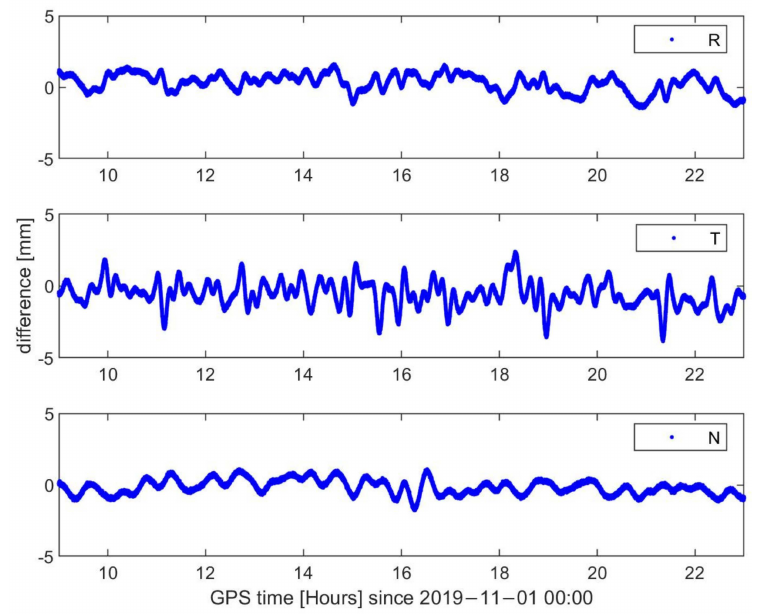
Figure 5. Difference between the NDT and CHS solutions on day of year (DOY) 305 in 2019 (excluding maneuver periods).